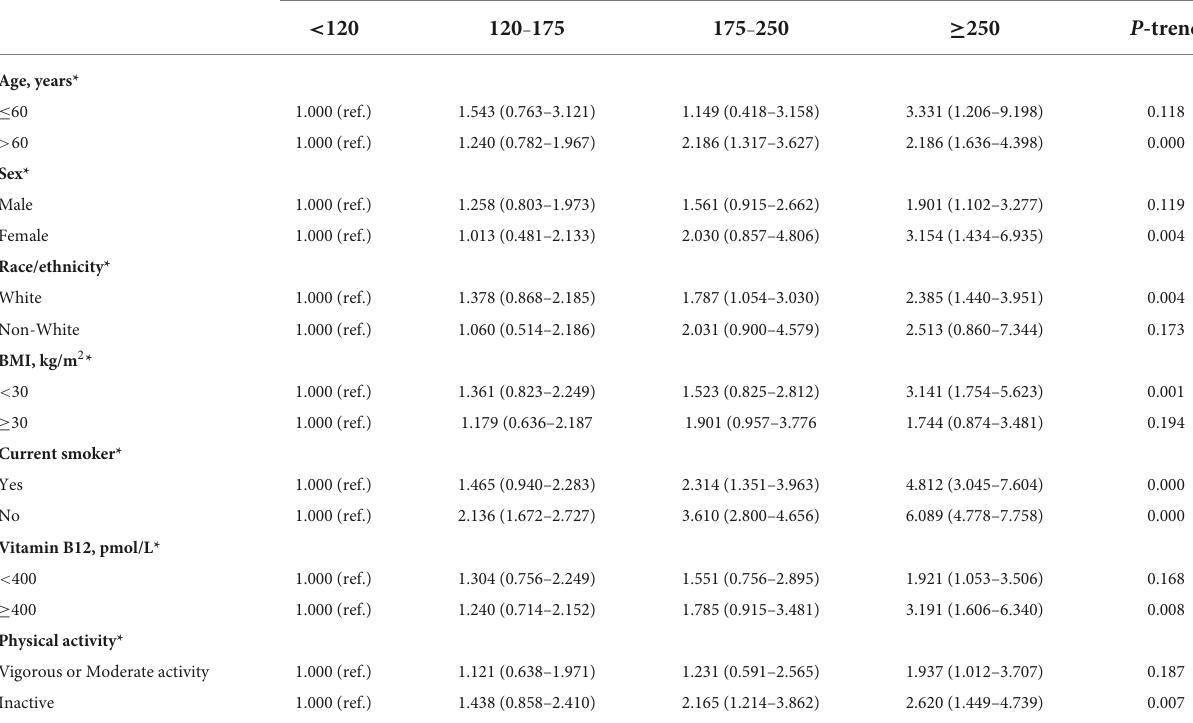
TABLE 3 Stratified analyses of the associations (hazard ratios, 95% confidence intervals [CIs]) between serum methylmalonic acid (MMA) concentrations and all-cause mortality among diabetes in National Health and Nutrition Examination Survey